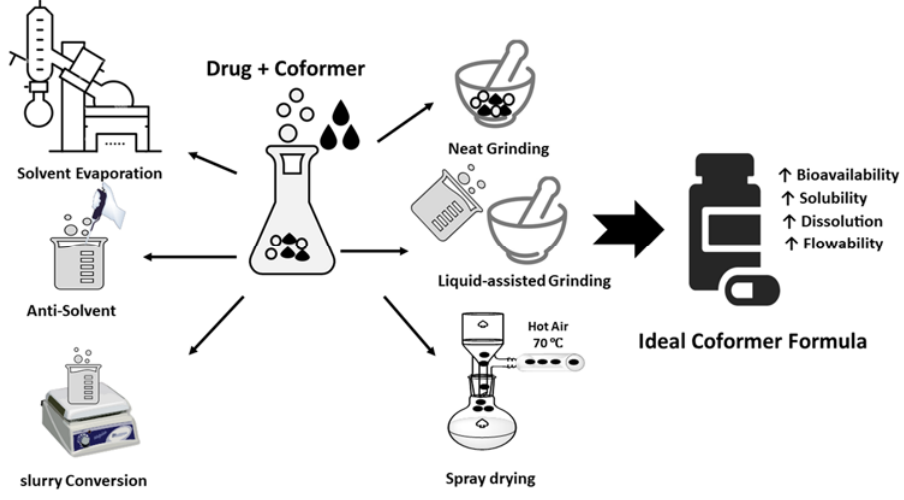
Figure 6. Coformer synthesis techniques.